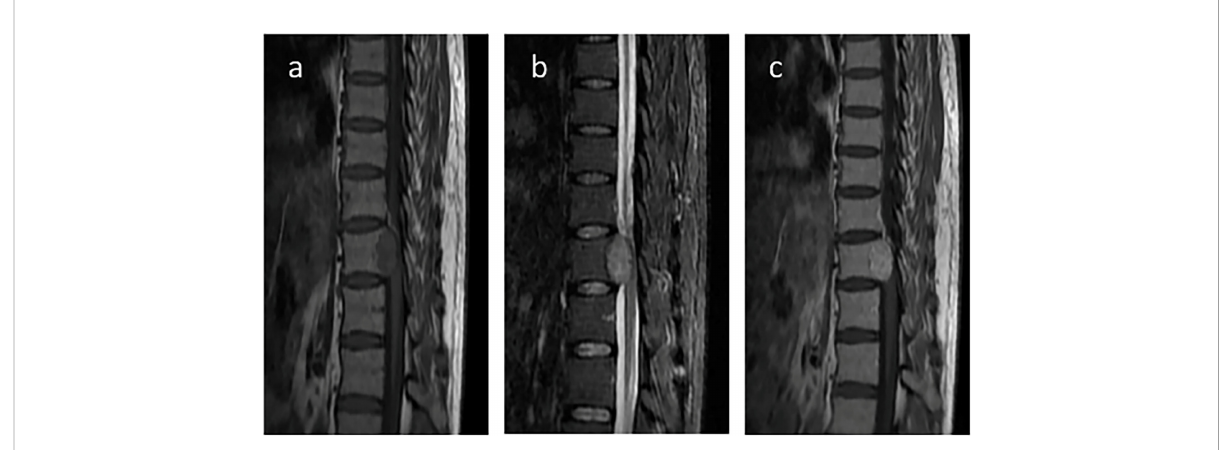
FIGURE 5 Contrast-enhanced magnetic resonance imaging (MRI) of the thoracic spine. Contrast-enhanced MRI of the thoracic spine con fi rmed thoracic spine metastasis and one metastatic nodule projected into the spinal canal and compressed the spinal cord. (A) T1WI; (B) T2WI; (C) T1WI